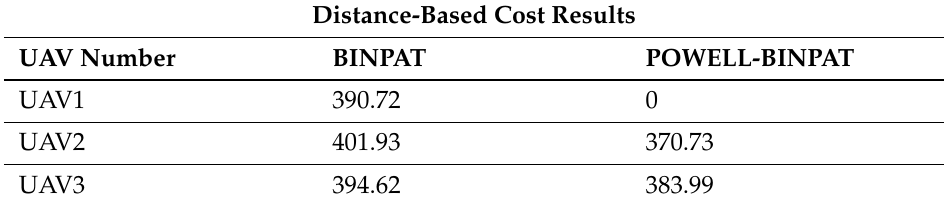
Figure 10. Optimal UAV assignment results with POWELL-BINPAT: ( a ) paths generated with BINPAT; and ( b ) paths generated with POWELL-BINPAT. Table 4. Cost-based results comparison.